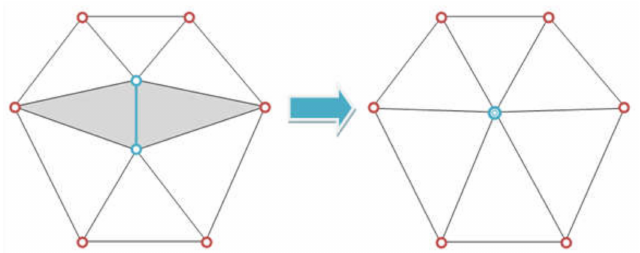
Figure 14. Illustration of edge collapsing technique, where the blue edge is collapsed into a single point. The shaded triangles degenerate and are removed during the